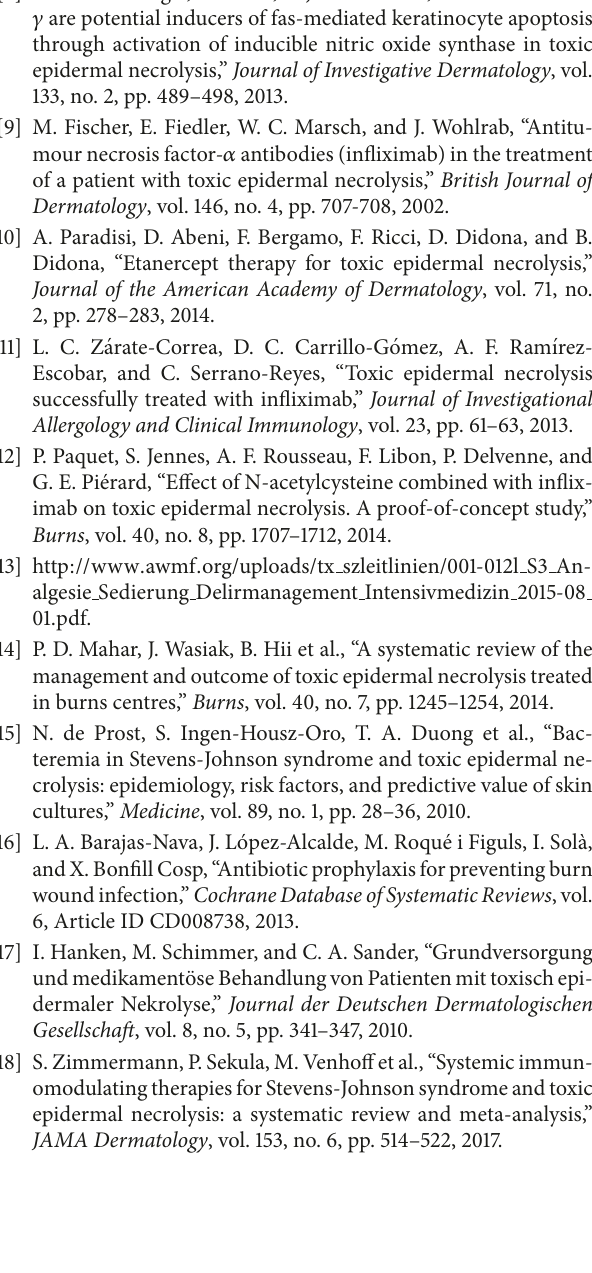
Table 2: Supportive care in